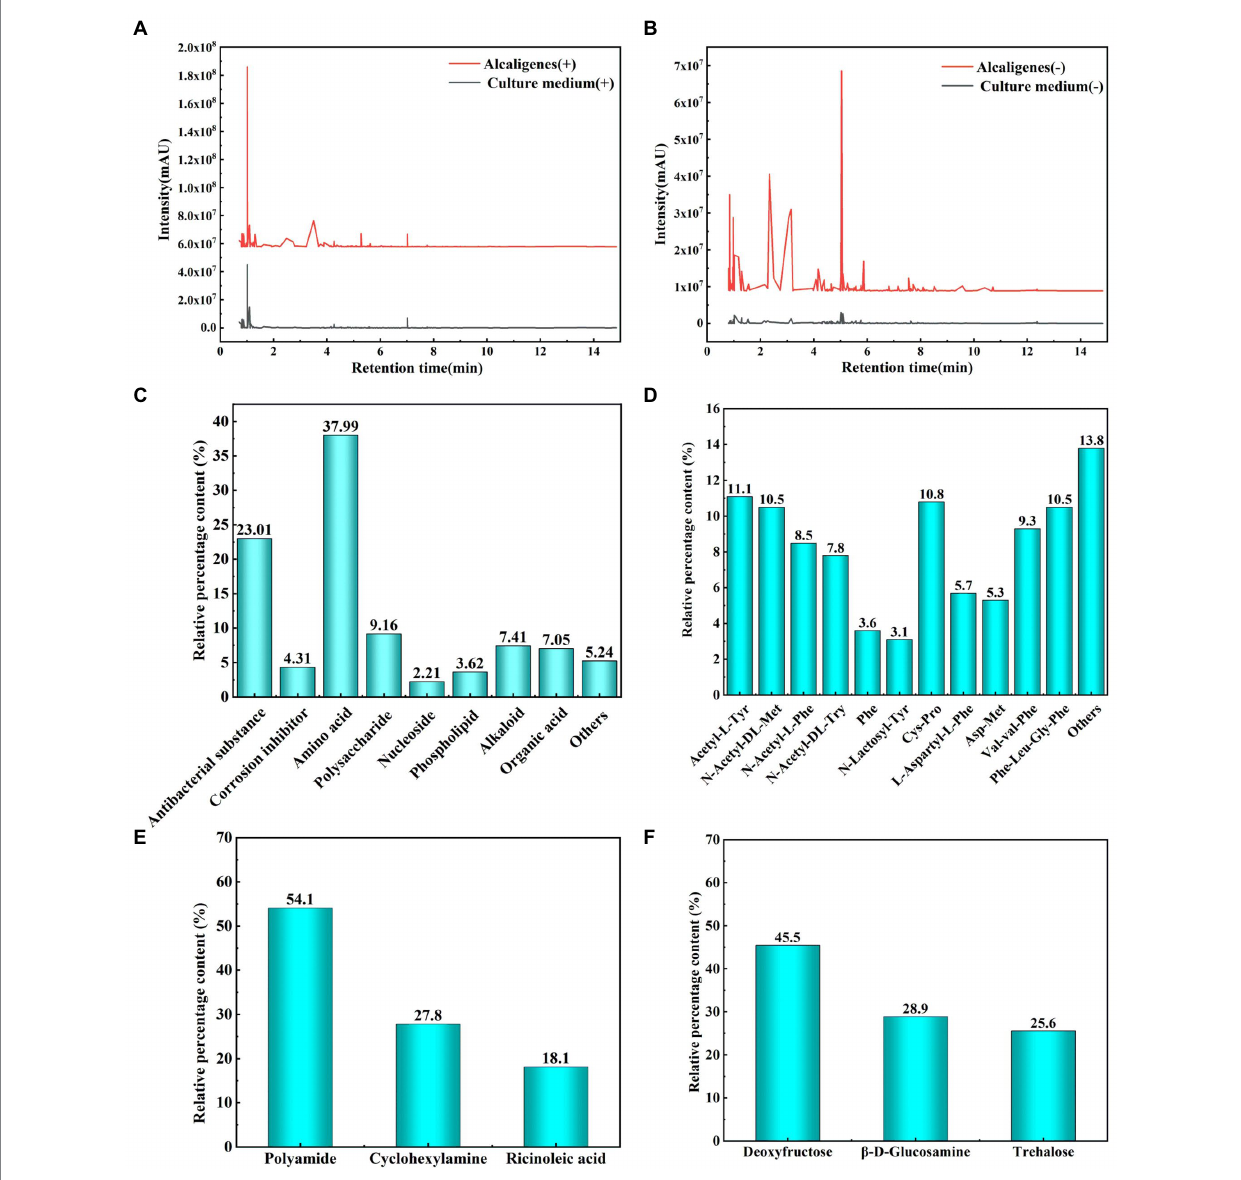
FIGURE 6 Analysis of metabolites of Alcaligenes sp. ( A : Metabolites correspond to positive ions; B : Metabolites correspond to negative ions; C : Total metabolites; D : Amino acids; E : Polysaccharides; F : Corrosion